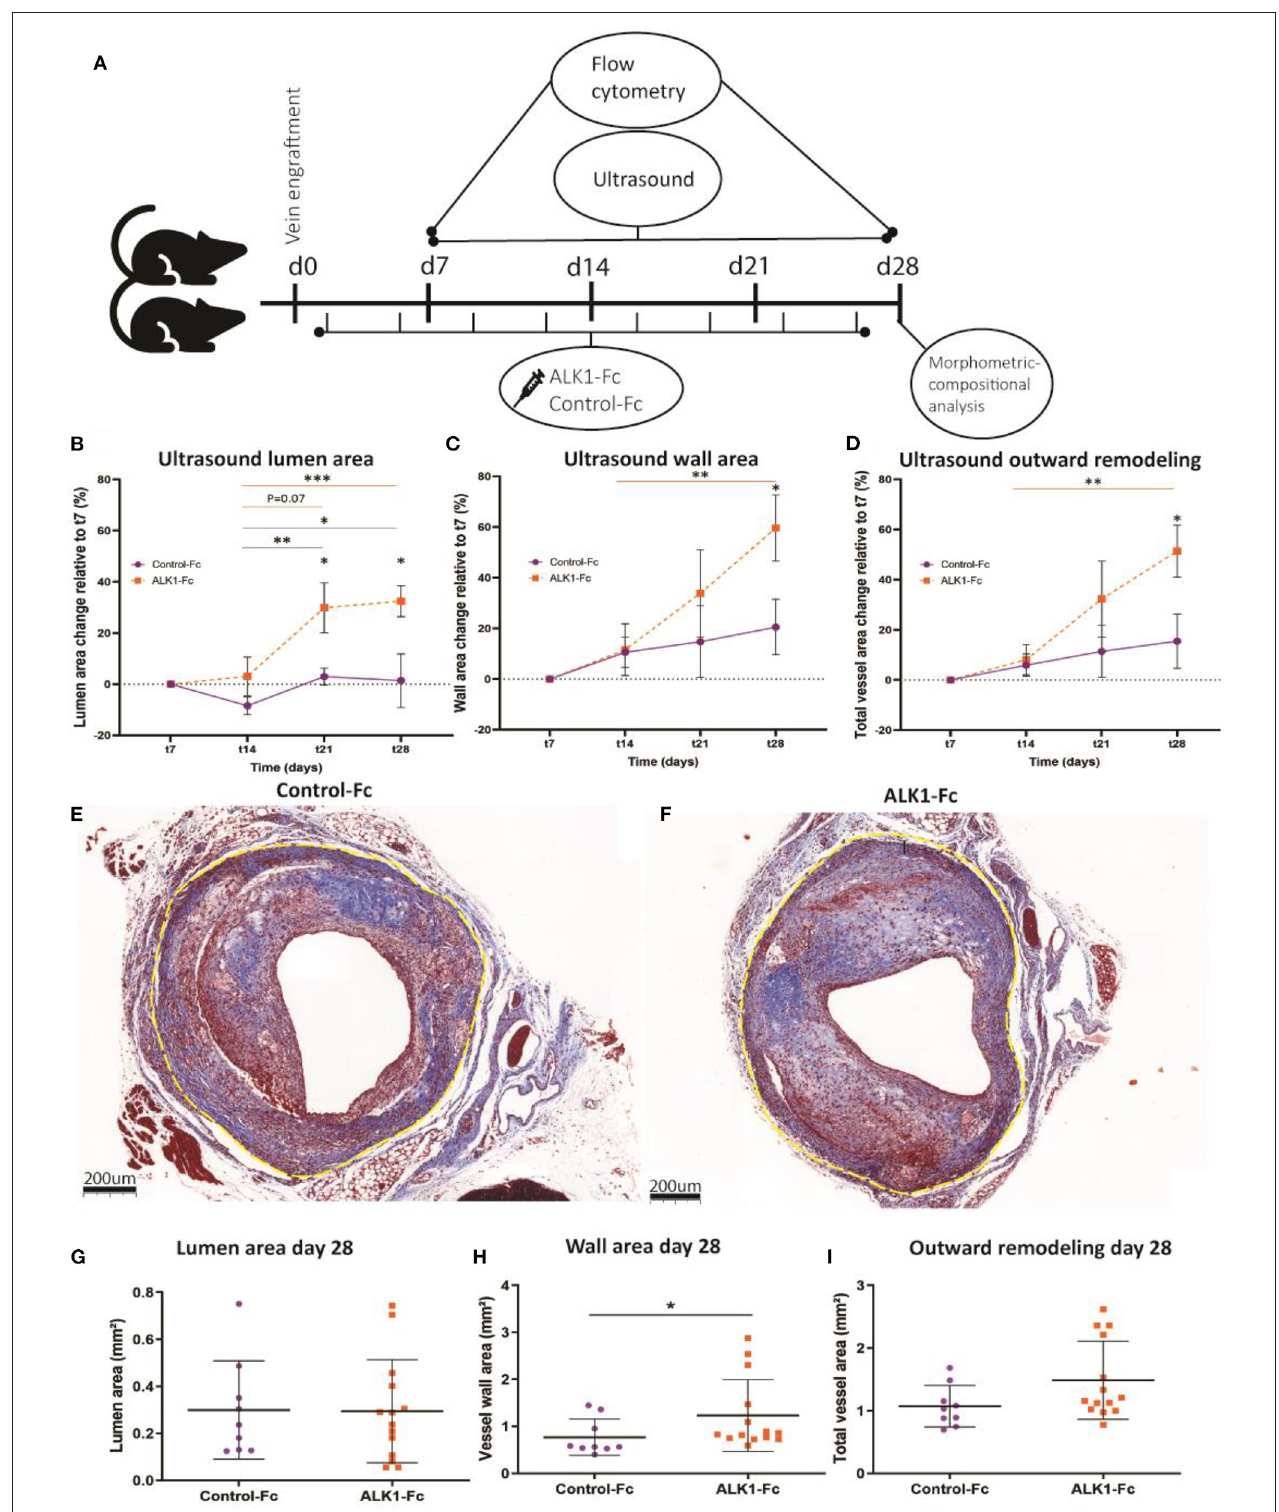
FIGURE 2 | Non-invasive ultrasound analysis and histology analysis of control-Fc and Alk1-Fc treated vein grafts. High fat/cholesterol-fed ApoE3*Leiden mice were treated with ALK1-1Fc or control-Fc (10 mg/kg) twice a week for 28 days. (A) Ultrasound measurements were performed in vein grafted ApoE3*Leiden mice